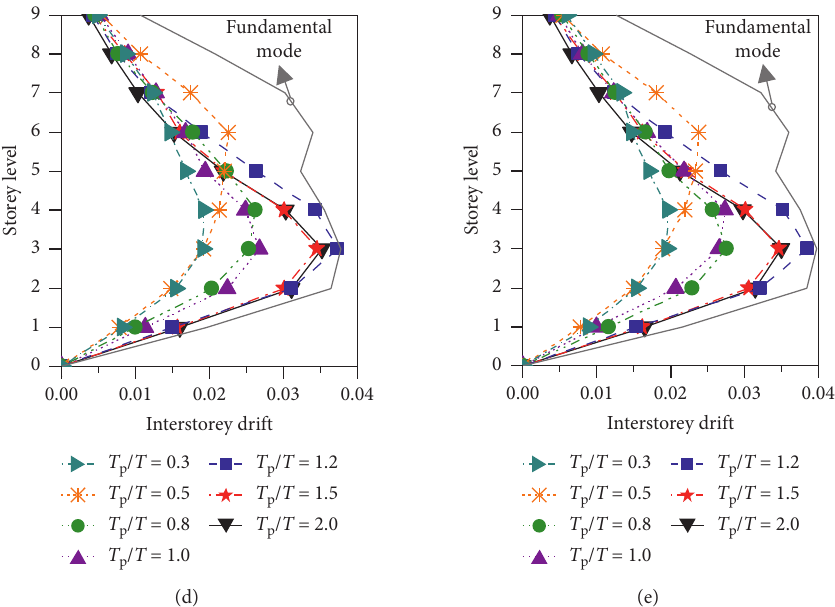
Figure 19: The interstorey drift of building-damper systems subjected to ANEs with different pulse periods. (a) BRB. (b) FD. (c) SCD. (d) VD. (e) VED.